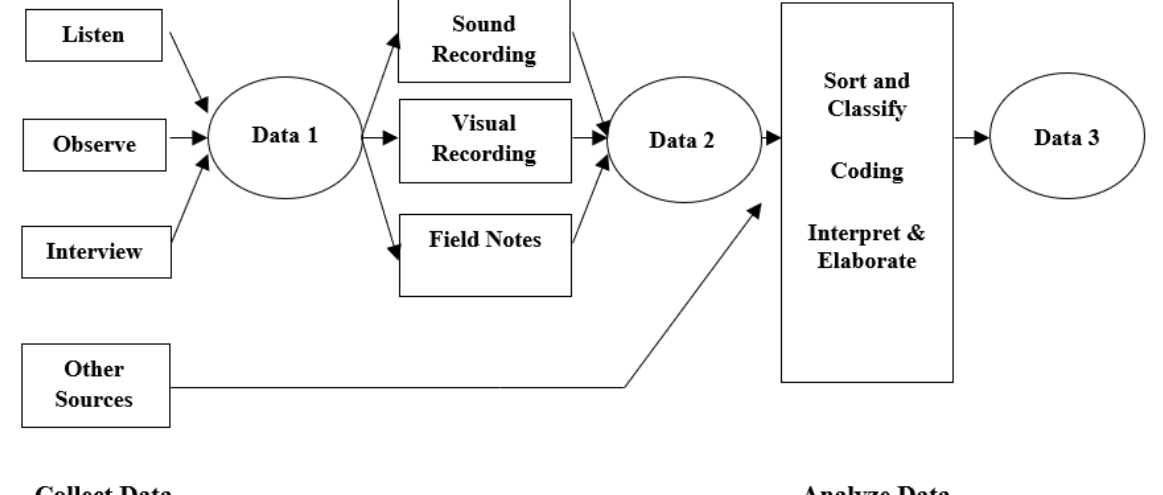
Figure 1. Data analysis process (modified from [24]).